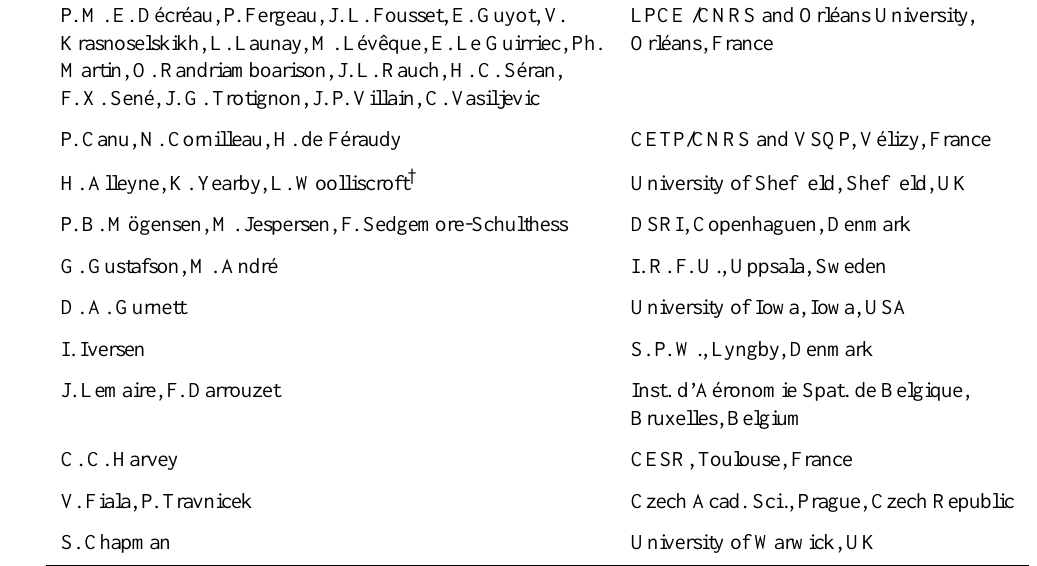
(Table 1), organised within the context of the Wave Experi- ment Consortium, which groups five instruments (Pedersen et al., 1997). The Whisper instrument consists basically of a receiver, a transmitter, and a wave spectrum analyser, com- pleted by the sensors of EFW (Electric Field Wave experi- ment), and functions of DWP (Digital Wave Processing ex- periment), which are two other WEC instruments. Whis- per is devoted to the survey, both active and passive, of the WEC electric signal in the high frequency range from about 2 to 80 kHz, which includes electrostatic and electromag- netic natural emissions of interest to the Cluster objectives. It includes emissions in the vicinity of the plasma